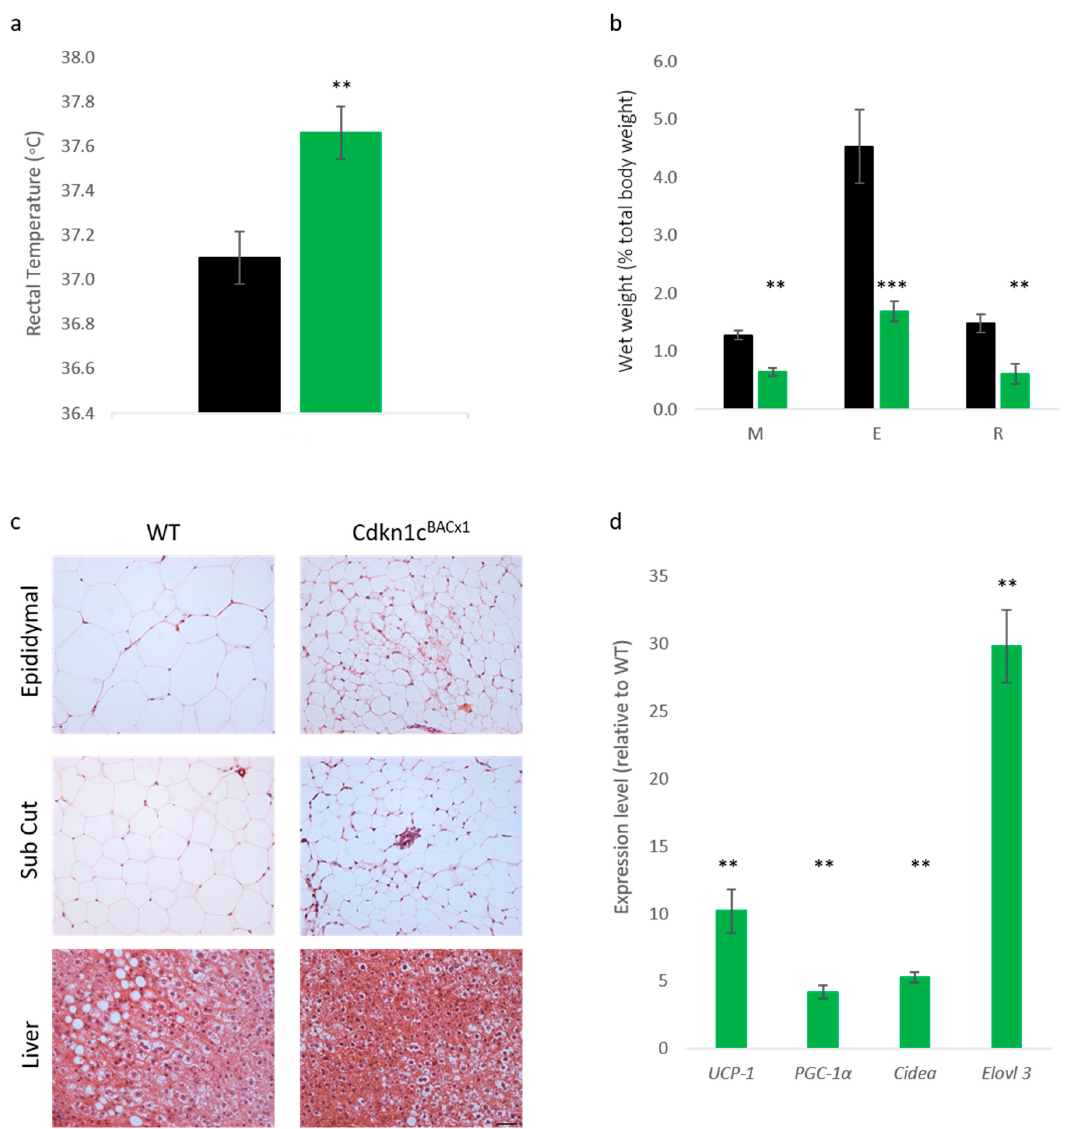
Figure 3. Cdkn1c BACx1 mice show reduced lipid stores and elevated brown adipose tissue (BAT) markers in high-fat diet (HFD)-exposed white adipose tissue. ( a ) Rectal temperature of adult male mice exposed to high-fat diet challenge. Cdkn1c BACx1 males (light green) had a significantly increased core body temperature when compared to WT littermates (black), (n: 9, 8), ** p < 0.01; ( b ) Wet weight of white adipose tissue in high-fat diet exposed males, as a percentage of total body weight. Mesenteric (M), epididymal (E) and retroperitoneal (R) depots were all found to be significantly smaller in Cdkn1c BACx1 males (light green) than WT (black). (n: 9, 8), ** p < 0.01, *** p < 0.001; ( c ) H+E staining of epididymal (top row), anterior sub-cutaneous (Sub Cut, middle row) white adipose and liver (bottom row) in WT (left column) and Cdkn1c BACx1 (right column) adult males exposed to high-fat diet challenge. Large unilocular cells were consistently observed in WT adipose depots, with lipid deposits clearly visible in liver sections. Smaller unilocular and multi-locular adipocytes were observed in Cdkn1c BACx1 sections, with sparse lipid deposits in liver sections (scale bar: 20 µm); ( d ) Quantitative RT-PCR analysis of brown adipose markers in retroperitoneal white adipose tissue, from adult male mice exposed to a high-fat diet. Significantly elevated markers of brown adipogenesis were detected in Cdkn1c BACx1 transcripts when compared to wild type (n: 4, 4). ** p < 0.01.